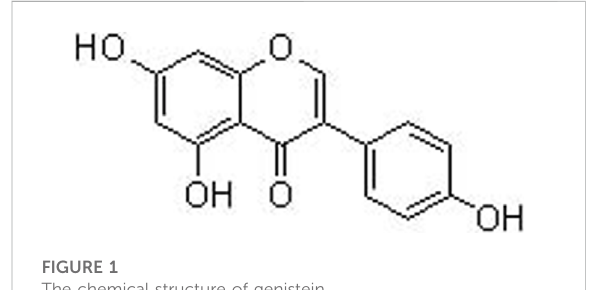
FIGURE 1 The chemical structure of